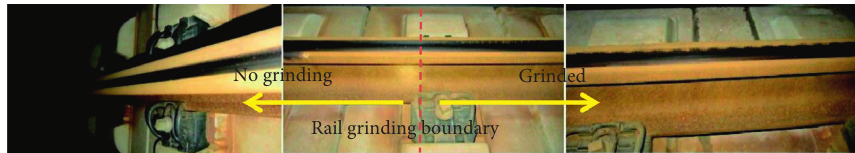
Figure 6: Picture of section with nonground and ground parts of the same rail in Section